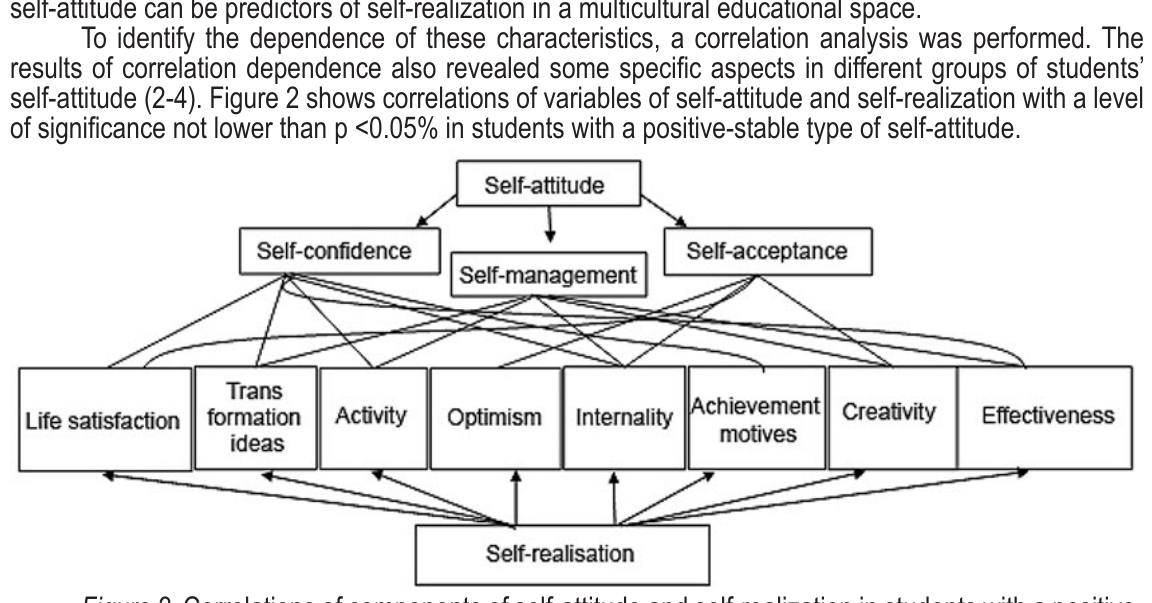
Figure 2. Correlations of components of self-attitude and self-realization in students with a positive- stable type.